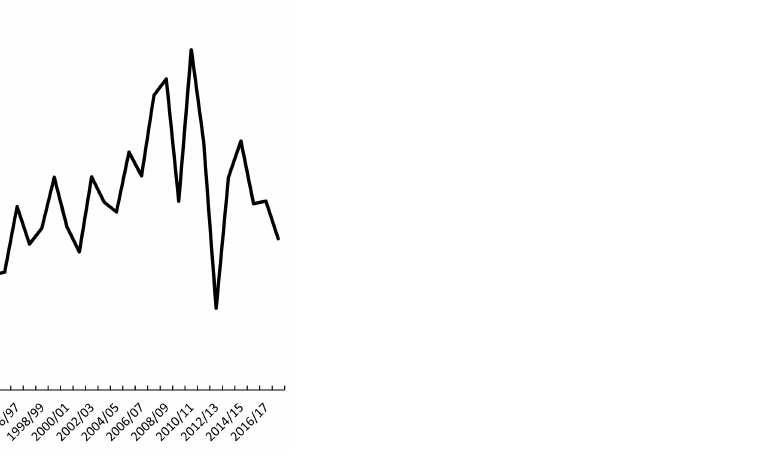
Figure 1. Annual rainfall trend in northern Namibia (Omahenene, 17 ◦ 27 (cid:48) S, 14 ◦ 47 (cid:48) E) over a 30-year